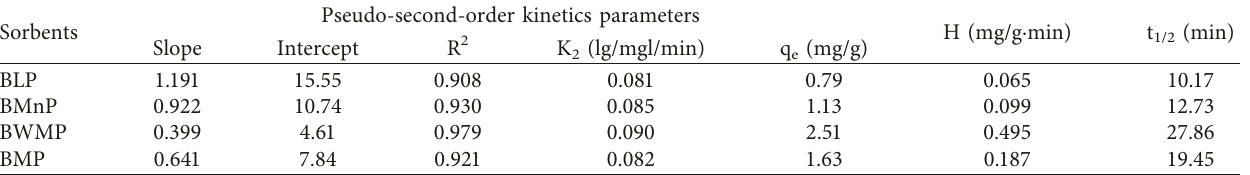
Table 5: Kinetic model data for the removal of Cr (VI) by base-treated samples. Pseudo-second-order kinetics Sorbents